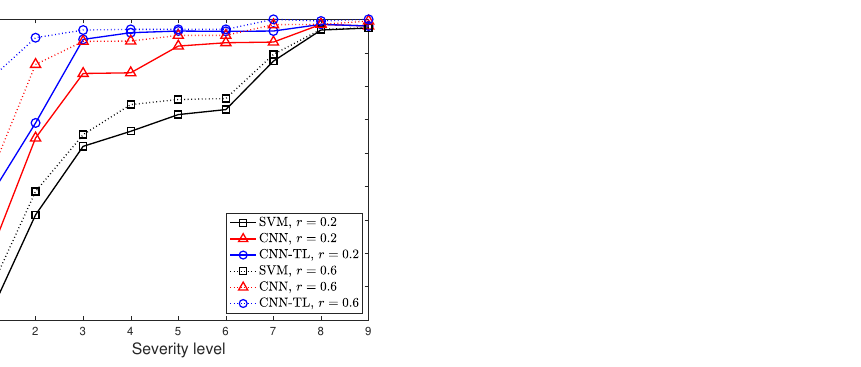
Figure 9. Classification accuracy of SVM, the CNN, and CNN–TL with different severity labels, l = 1, . . . ,9.